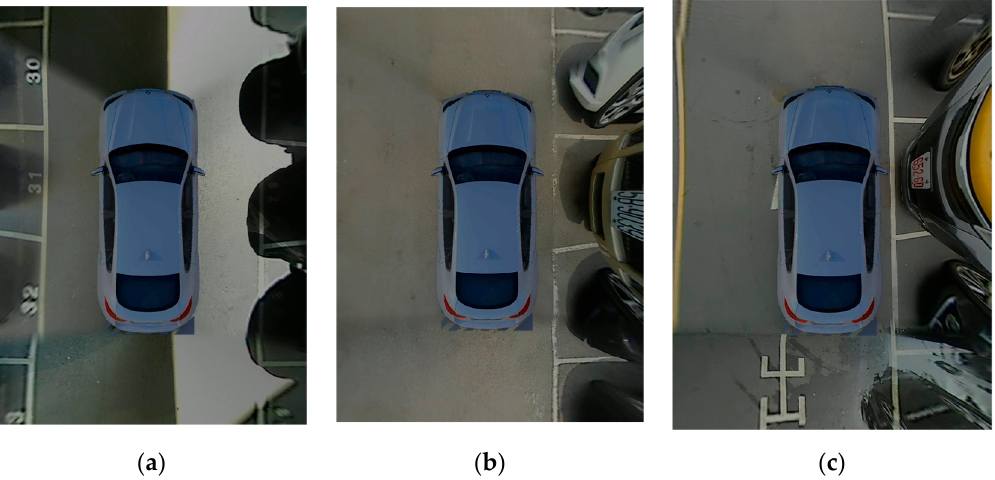
Figure 26. Examples of parking space detection failures. ( a ) Dark shadows; ( b ) Severely damaged markings; ( c ) Puddle.